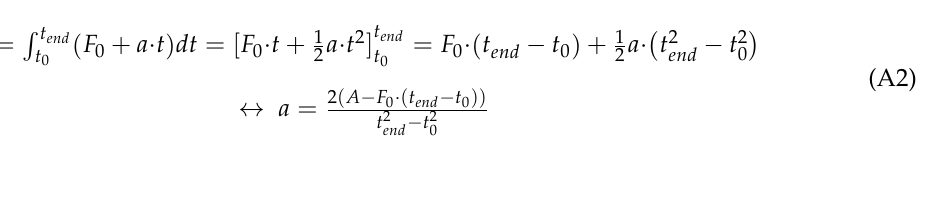
Figure S1: Cultivation data regarding growth at different applied cultivation conditions, Figure S2: Specific rates for growth µ , substrate consumption q S and product formation q P regarding different applied cultivation conditions, Table S1: Layout of experimental conditions, Table S2: Volumetric and specific enzyme activity (EA) after 23 h and 37 h cultivation time, Table S3: Acetate, lactate, ammonia and phosphate concentration at 32 h cultivation